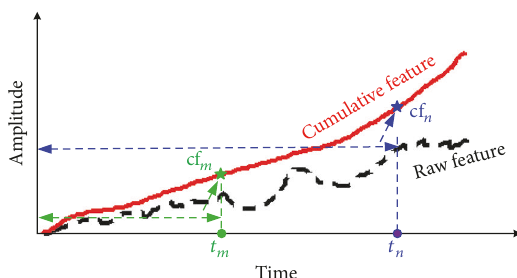
Figure 1: Diagram of cumulative